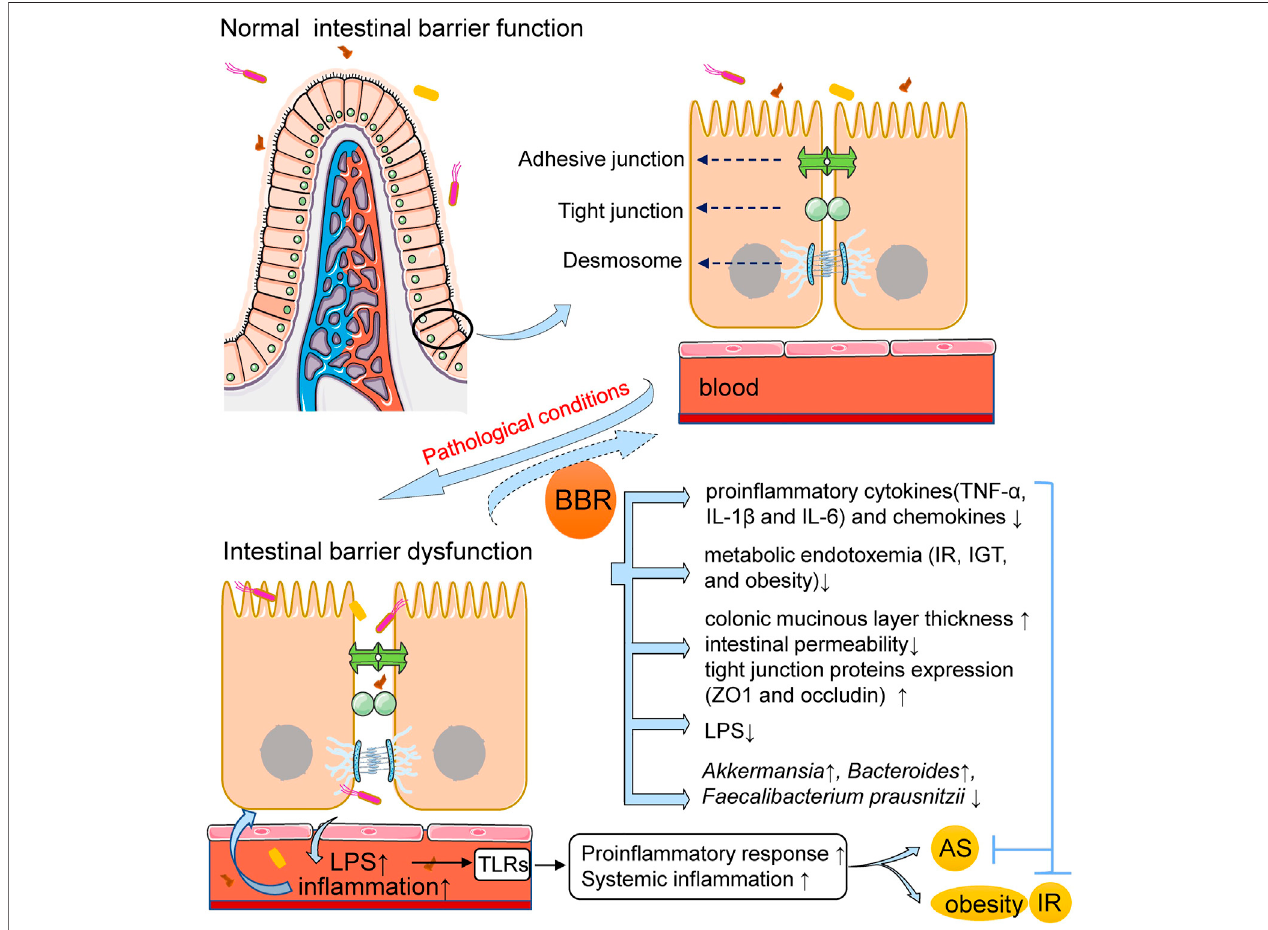
FIGURE 1 | BBR improves intestinal barrier dysfunction and reduces in fl ammation in AS and metabolic diseases. Under the pathological conditions of AS and metabolicdiseases,theintestinalpermeabilityisincreased,resultinginthedisplacementofgutbacteriaandits-derivedLPSintocirculationandtheactivationofsystemic in fl ammatorypathways.BBRadministrationcanimproveintestinalbarrierdysfunctionandreducein fl ammation.ThemechanismmayinvolvethatBBRincreasescolonic mucinouslayerthicknessandintestinaltightjunctionproteinexpression,bothofwhichareassociatedwiththerestorationofintestinalbarrierintegrity;BBRreduces theexpressionofpro-in fl ammatorycytokinesandchemokines,decreasesplasmaLPSlevelsandimprovesendotoxemia.Thealterationingutmicrobiotacompositionis correlated with the above effects of BBR. AS, atherosclerosis; BBR, berberine; IR, insulin resistance; IGT, impaired glucose tolerance; LPS, lipopolysaccharide; ZO1, zonula occludens 1; TLRs, toll-like receptors; TNF- α , tumor necrosis factor- α ; IL-1 β , interleukin-1 β